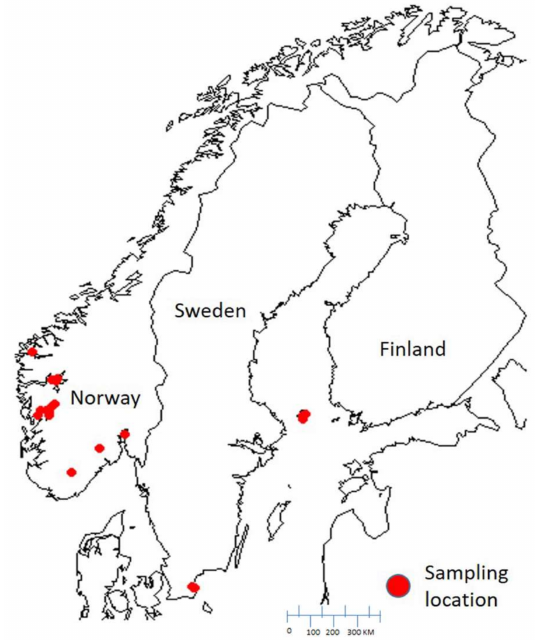
Figure 3. The geographical locations of the sampling areas. The sampling of Argyresthia conjugella was based on their exact global position coordinates